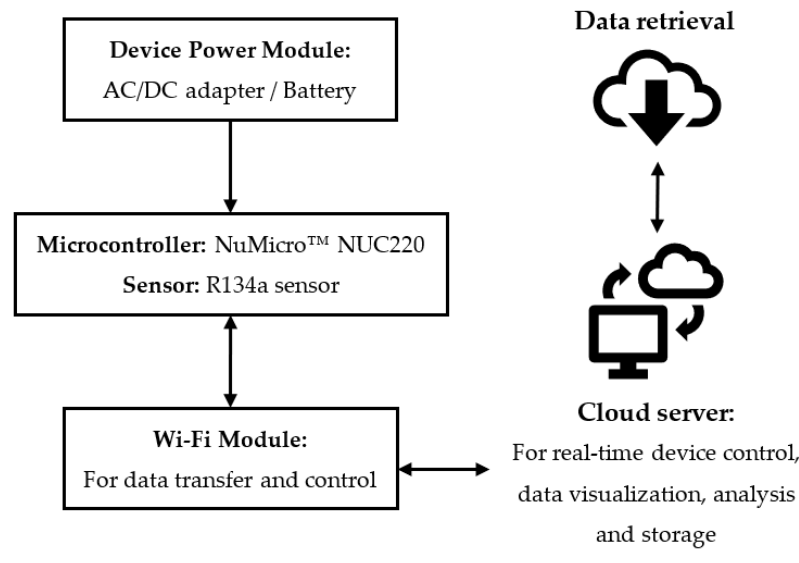
Figure 1. Operational diagram of the tracer gas system.